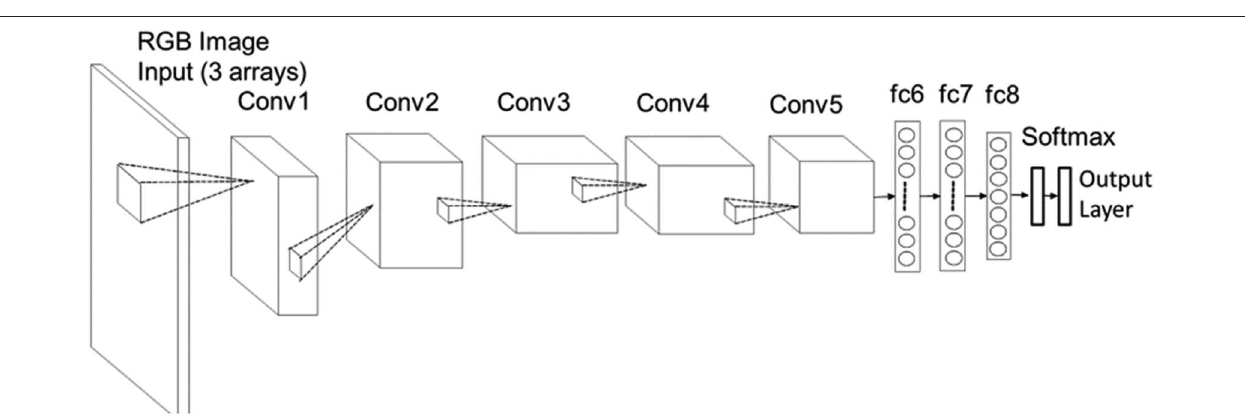
the RGB format was based on the Matlab “ jet ” colormap (MathWorks, 2018). The 64 colors of the “ jet ” colormap provided weights allowing to split each pixel value of the original